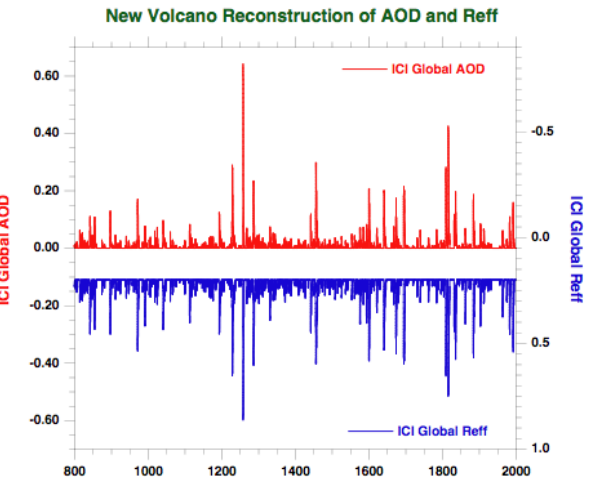
Figure 9. A further independent test of AOD calibration for 1883 Krakatau eruption, using lunar AOD data from Keen (2001). Note that the second “bump” in the reconstruction reflects the addition of new aerosol from the 1886 Okataina eruption on New